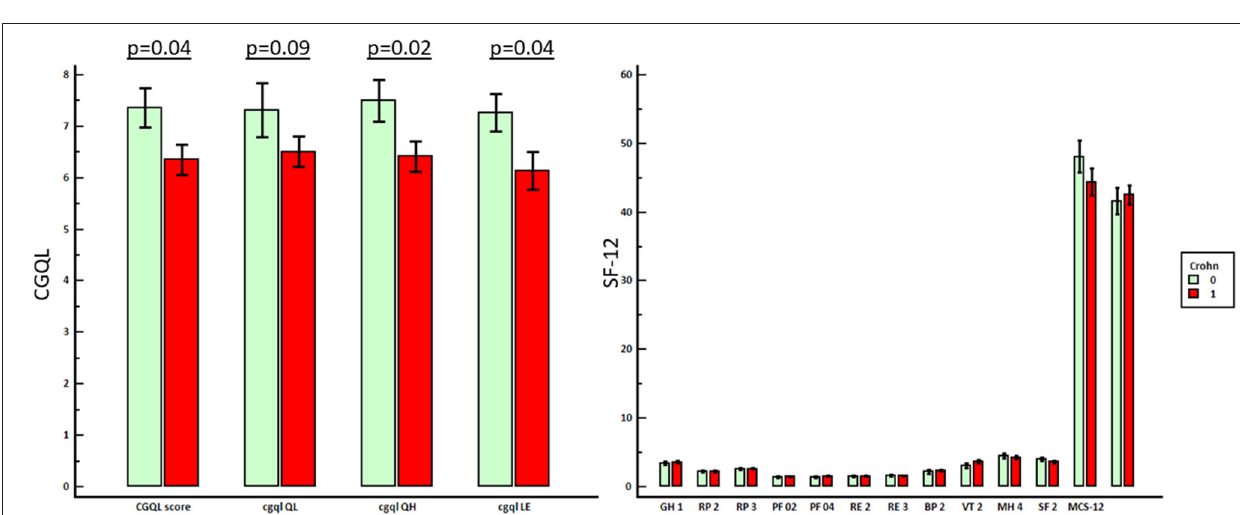
(PCS) deriving from the ampler SF-36 (20). Disease activity was quantified with the Harvey-Bradshaw Activity Index for CD that includes 5 items covering symptoms of patients with CD